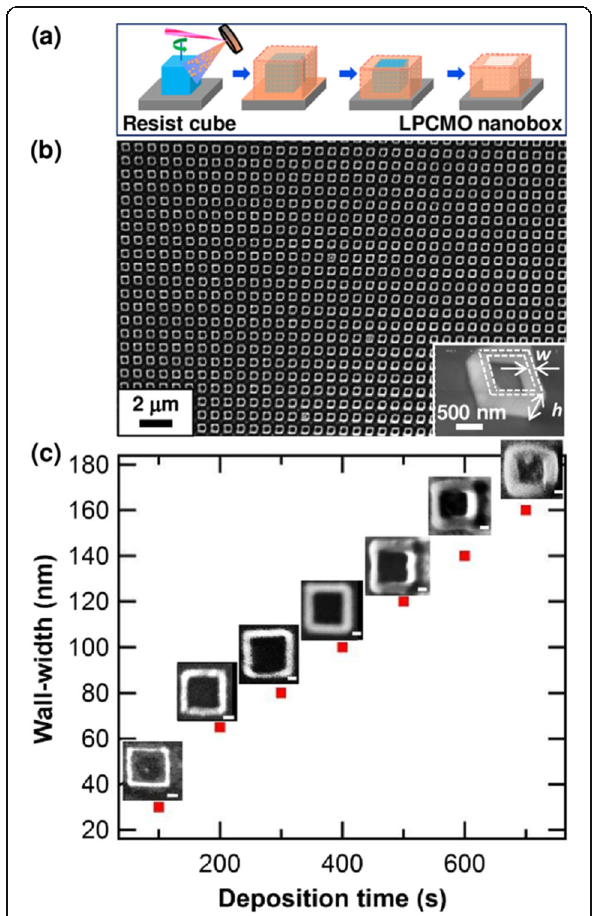
Fig. 2 a Schematic image for the fabrication procedure of the